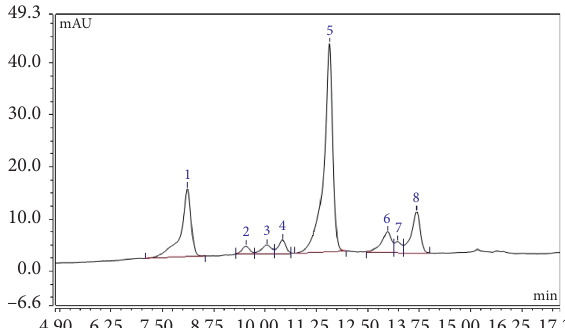
Figure 3: The chromatogram of polyphenol compounds—anthocyanins of blue maize line CHIH 503. Identified anthocyanins are 1—cyanidin-3- glucoside, 2—pelargonidin-3-glucoside, 3—pelargonidin-3-glucoside, 4—peonidin-3-glucoside, 5—cyanidin-3-(6 ′ -malonylglucoside), 6—pelargonidin-3-(6 ′ -malonylglucoside), 7—peonidin-3-(6 ′ -malonylglucoside), and